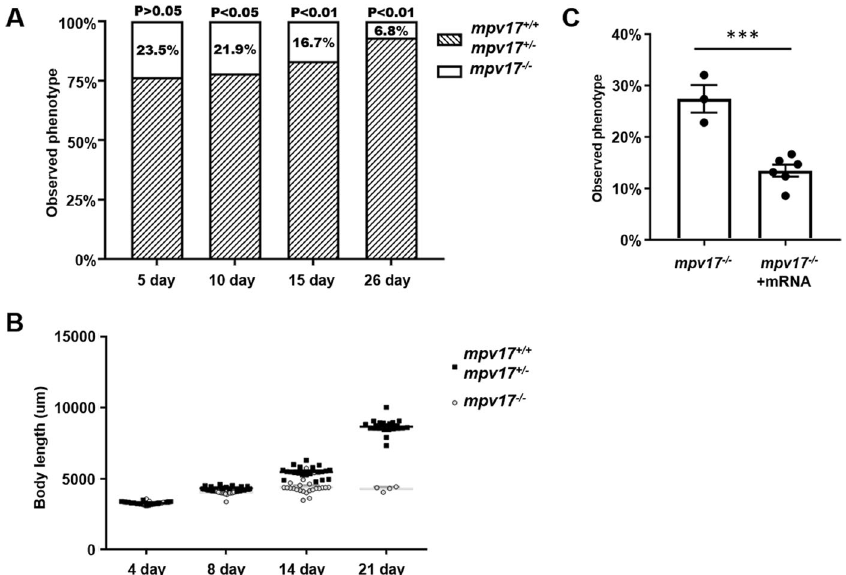
Fig. 2 The mpv17 − / − zebra fi sh has a poor growth condition and low survival ratio, but can be recovered by mpv17 mRNA. A The mpv17 − / − zebra fi sh exhibited a decreased survival ratio in the fi rst month. n = 1160 for 5 dpf, 993 for 10 dpf, 227 for 15 dpf and 176 for 26 dpf. B The growth of the mpv17 − / − zebra fi sh was decreased and even stopped after 14 days. The difference in the average length between mpv17 − / − and the pooled ( mpv17 + / + and mpv17 + / − ) larvae was increased. C The mpv17 mRNA can rescue the mpv17 − / − zebra fi sh, and the proportion of mpv17 − / − zebra fi sh in the rescue group was less than the control. Error bars were indicated with ±SEM, *** p <